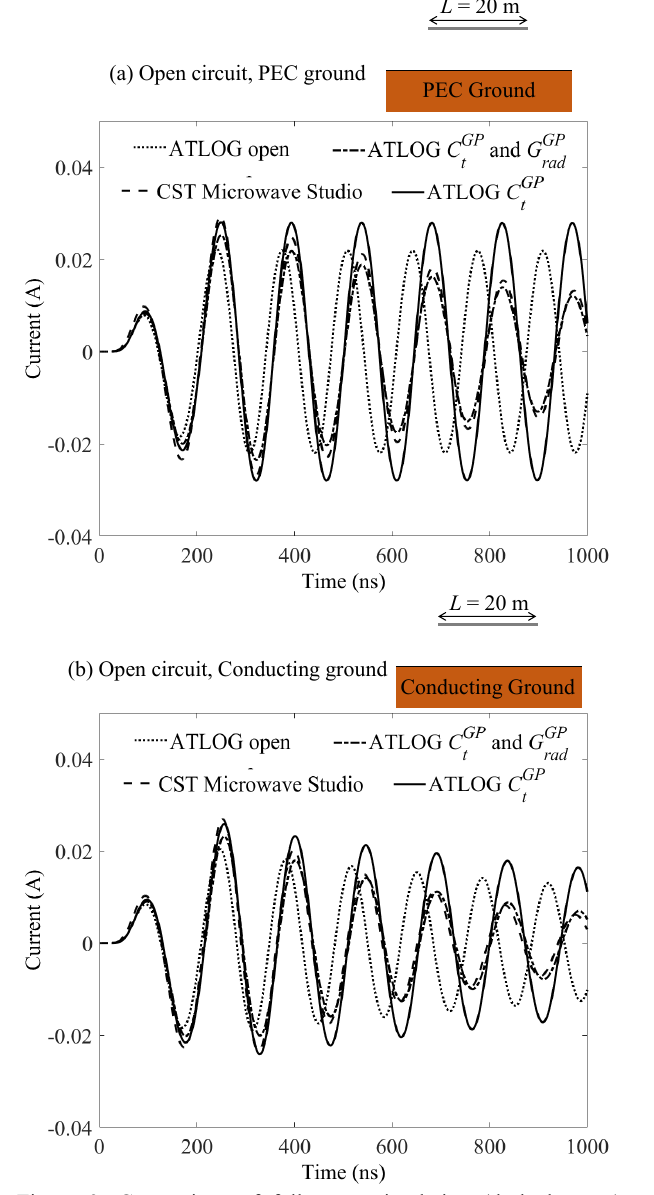
Figure 3: Comparison of full wave simulation (dashed curve) using CST Microwave Studio with the ATLOG transmission line calculations for a 20 m long section of line over (a) perfectly conducting ground and (b) a conducting ground with relative permittivity of 20 and conductivity of 0.01 S/m having open circuits at both ends. The dotted curve has idealized open circuits at each end, the solid curve has terminating capacitors at each end, and the dash-dot curve has terminating capacitors and radiation conductances at each